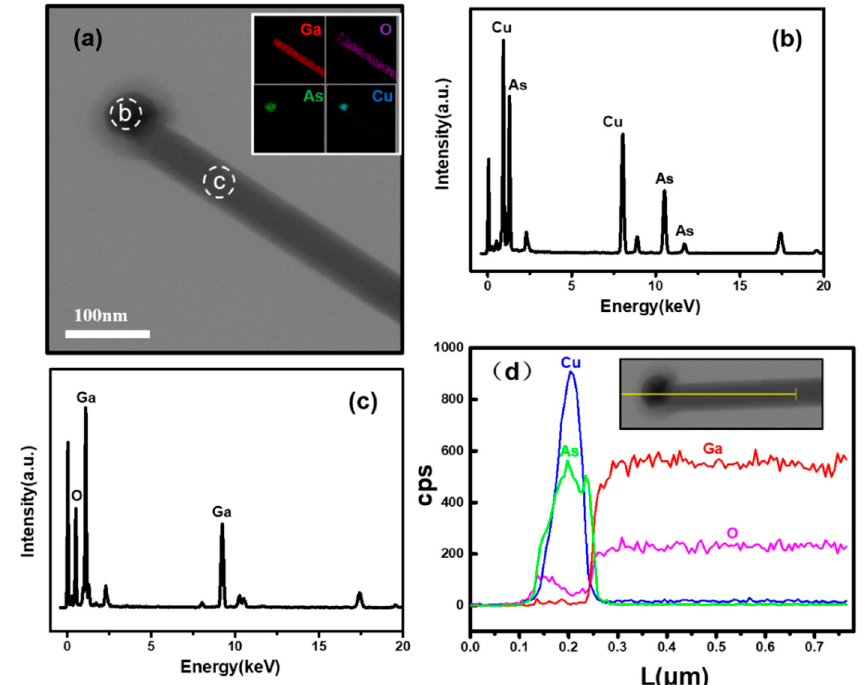
Figure 3. Elemental distribution of the NWs. ( a ) TEM image of a typical Ga 2 O 3 NW and inset is EDS mapping of the NW, ( b ) EDS spectrum of the tip, ( c ) EDS spectrum of the NW body, and ( d ) EDS line scan along this NW. The curves indicate the distribution of Cu, As, Ga, and O elements along the axial direction of the NW. It can be clearly seen that the wire is Ga 2 O 3 and the catalyst tip is the Cu-As alloy.